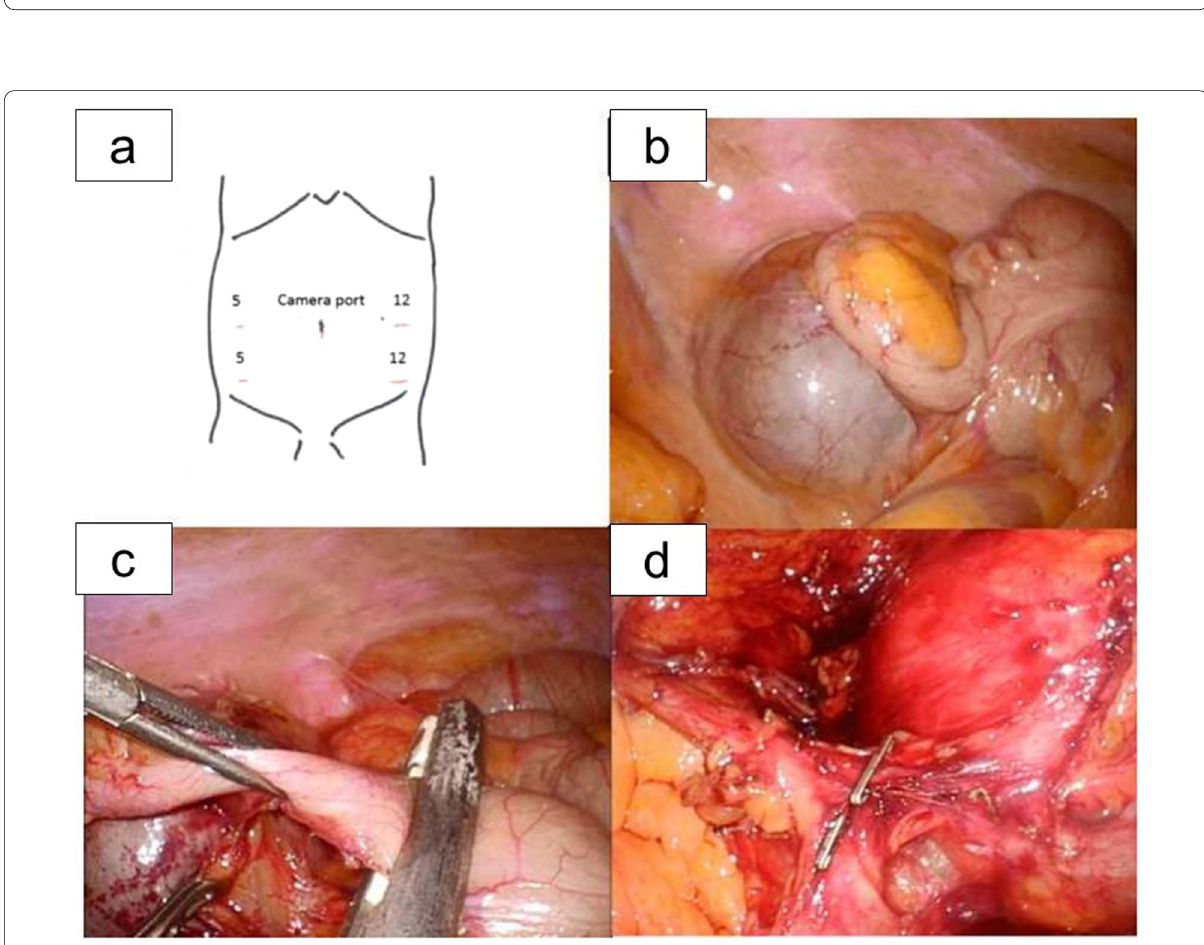
Fig. 3 Laparoscopic resection of the isolated enteric duplication cyst. Laparoscopic resection was performed using 5 trocars ( a ). The large cystic mass was identified below the right kidney. It firmly adhered to the appendix and mesentery via the retroperitoneum ( b ). The appendix was dissected with a linear stapler and resected en bloc with the cystic lesion ( c ). Some feeding vessels from the right gonadal vessel were clipped and cut ( d